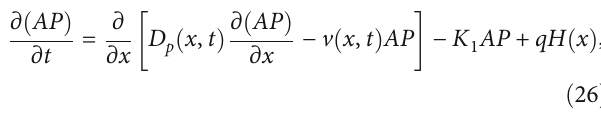
ð x , t Þ and P ð x , t Þ with 100 mesh points by Δ x = 0 : 1 and Δ t = 0 : 01 1 2